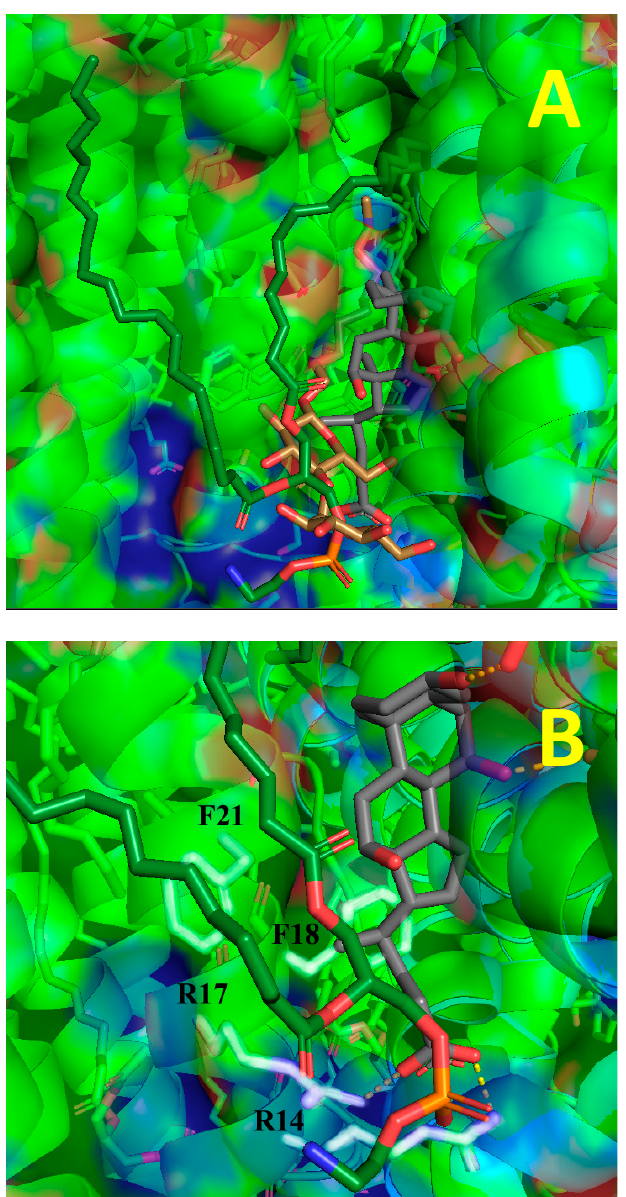
Figure 2. BABS with the ligand and adjacent endogenous lipid. ( A ) The BABS region from the mitochondrial dimeric CcO structure (PDB entry 5B1A) is depicted as a protein surface. The endoge- nous phosphatidylethanolamine molecule is shown by dark green sticks. Decyl maltoside (brown sticks) from R. sphaeroides ’s CcO structure (PDB entry 3DTU) is superimposed on the image in the appropriate location. The cholate molecule (grey sticks) is bound in the hydrophobic cavity formed by subunits I, II and VIa (from the opposite monomer). Side view, matrix is at the bottom. Oxygen and nitrogen atoms are colored in red and blue, respectively. ( B ) The same (except for the detergent from the bacterial enzyme structure), but enlarged. The residues of subunit VIa, presumably involved in interactions with cholate (Arg14, Arg17, Phe18 and Phe21), are indicated and tinted in white. The isolation of the His-tag-containing quinol oxidase bo 3 from E. coli using